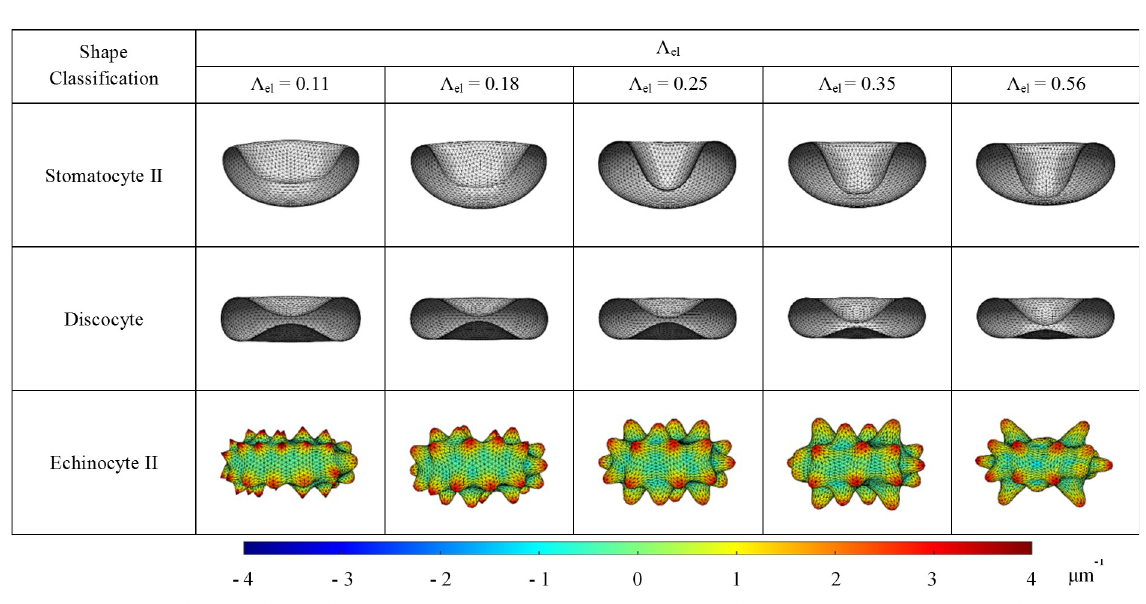
Fig 7. CG-RBC membrane model predicted stomatocyte II, discocyte and echinocyte II shapes at varying elastic length scale, Λ 0.18, 0.25, 0.35 and 0.56. The coloured regions of the echinocyte II shape represent the membrane curvature on its’ vertex points C